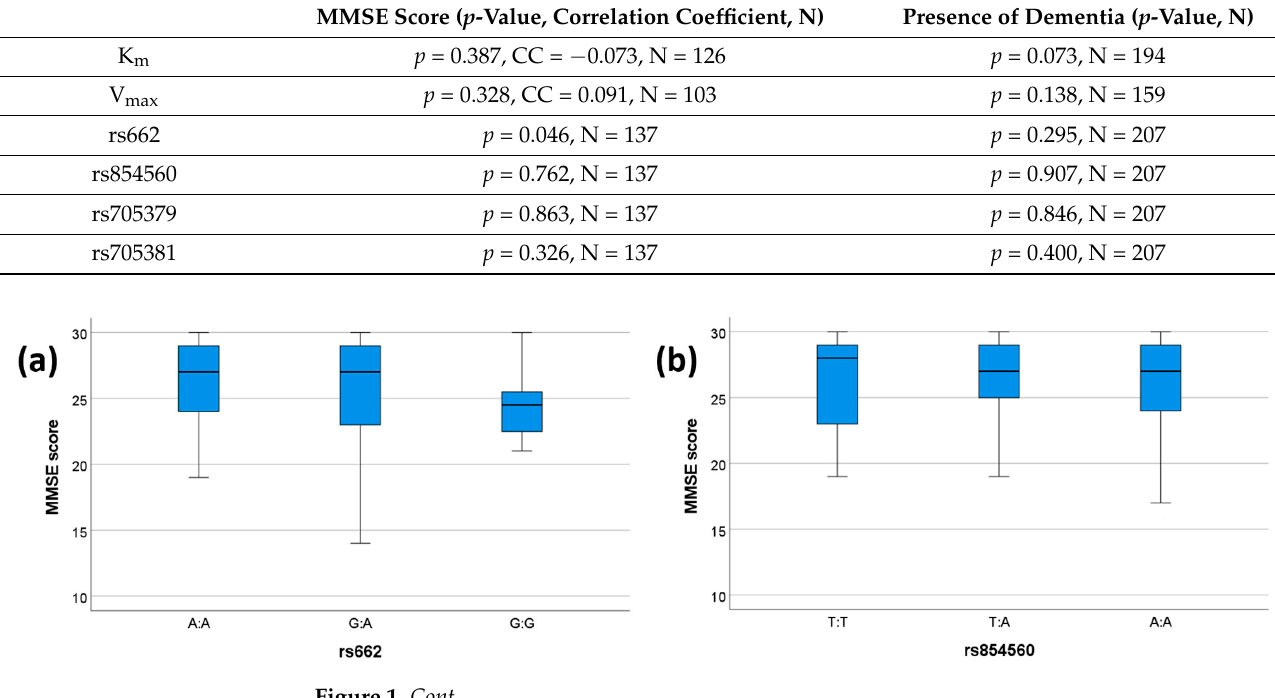
Figure 1. MMSE scores for each genotype. The box plots display the 5-, 25-, 50-, 75-, and 95- percentage intervals for the genotypes ( a ) rs662, ( b ) rs854560, ( c ) rs705379, and ( d ) rs705381. The medians (interquartile ranges) are displayed above each box plot. MMSE: mini mental state examination. For ( a ), N (AA) = 75, N (GA) = 51, N (GG) = 11. For ( b ), N (TT) = 18, N (TA) = 61, N (AA) = 58. For ( c ), N (AA) = 37, N (GA) = 55, N (GG) = 45. For ( d ), N (TT) = 14, N (TC) = 42, N (CC) = 81. We also tested whether there is any association between dementia status/MMSE on the one hand and PON1 kinetic parameters on the other hand for the reaction with DHC. MMSE scores did not correlate with any of the kinetic parameters (Table 7) or dementia status (Figure 2); however, a trend was observed ( p = 0.073 for K m ). Patients with dementia had a median K m value of 5.62 μ M (IQR = 4.79–6.78 μ M), whereas those without dementia